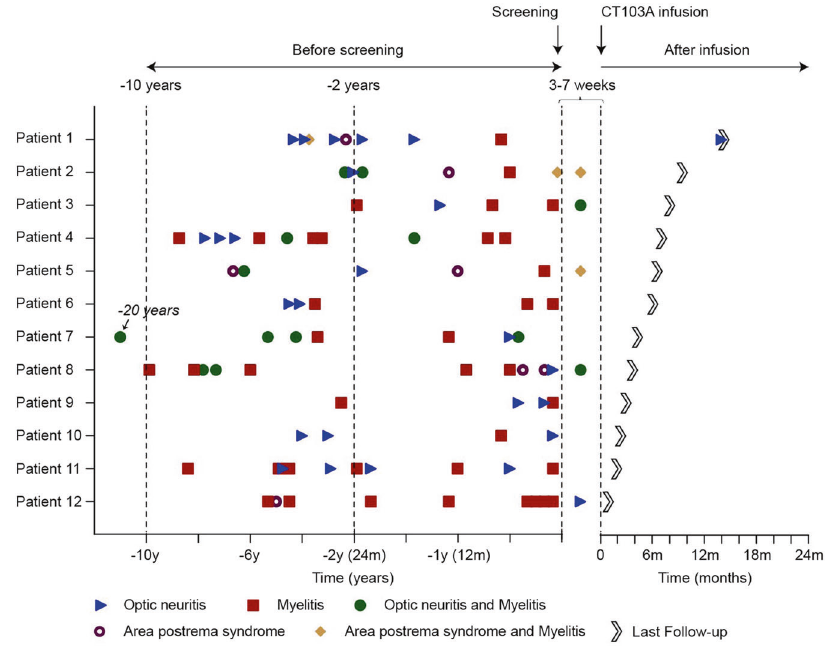
Fig. 2 Attack frequency before, during, and after CAR T